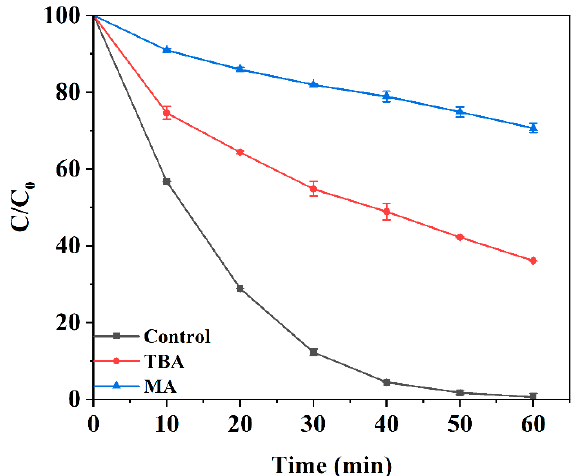
Figure 4. Effect of TBA and MA on IBU degradation. ((initial IBU concentration) = 30 mg/L, (Fe 3+ concentration) =2 mM, (PDS concentration) =12 mM, current density =15 mA/cm 2 , initial pH = 3, (MA concentration) = 500 mM, (TBA concentration) = 500 mM).